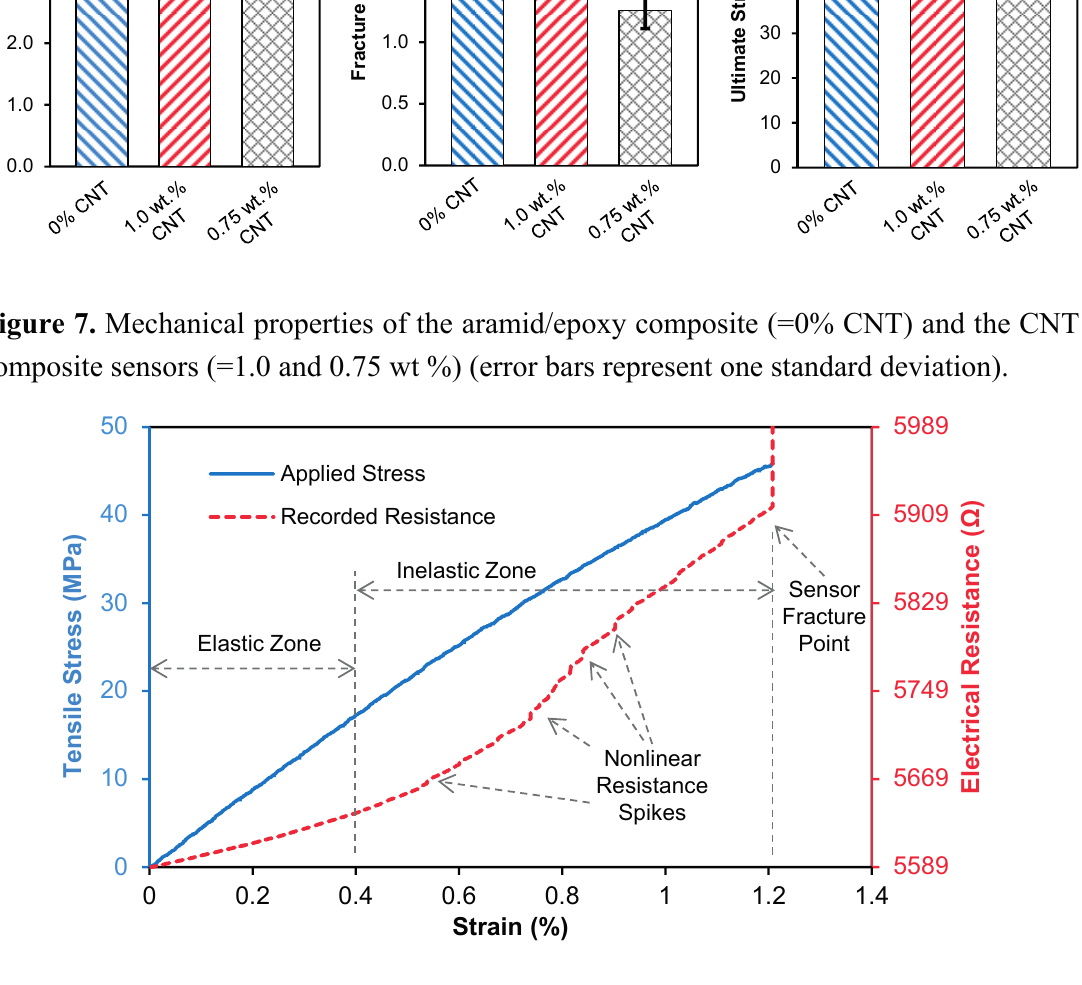
Figure 8. Typical stress and electrical resistance vs. strain responses of CNT composite